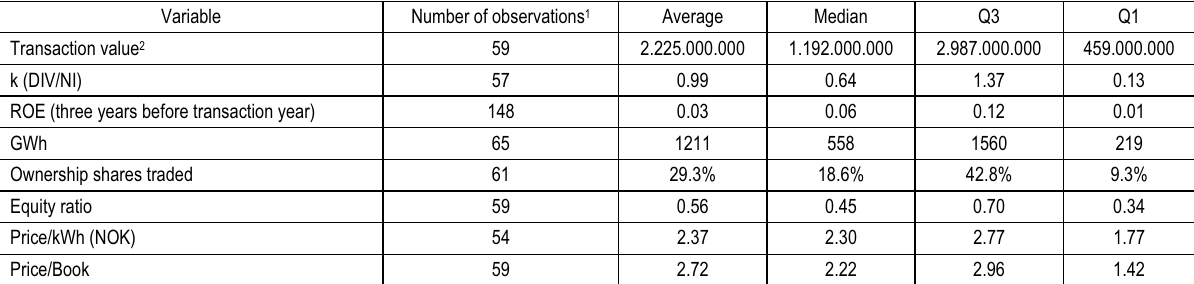
Table 2. Descriptive statistics of the companies and transactions in the